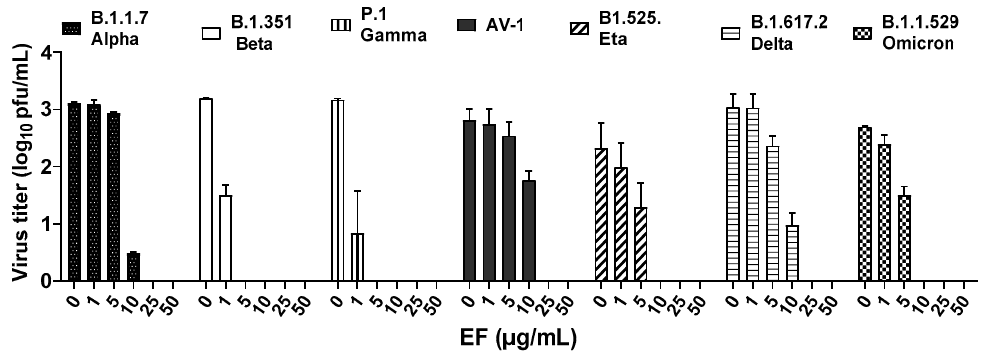
Figure 1. EF extract fully inhibited infectivity of all investigated variants of concerns (VOCs) at concentrations ≥ 25 µg/mL.